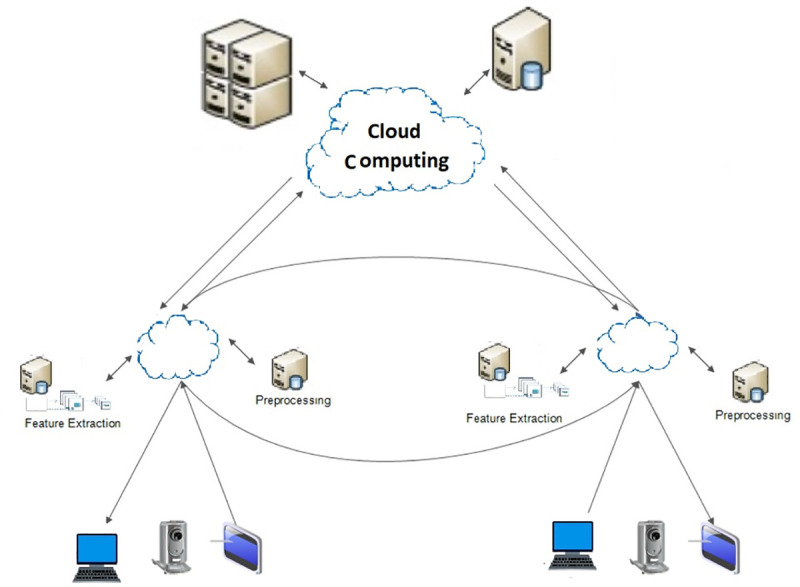
General block diagram of the fog computing FR system.